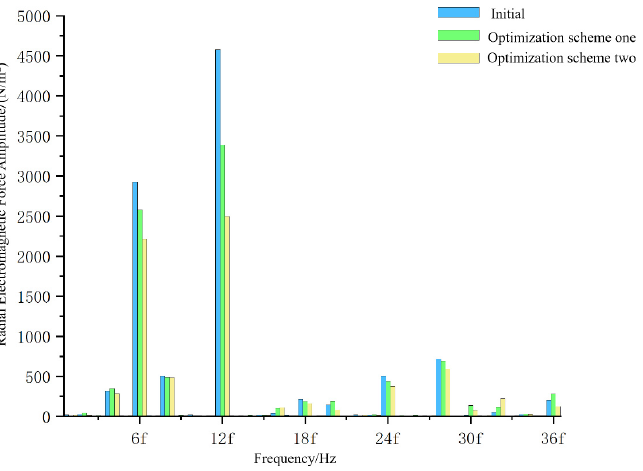
Figure 8. Zeroth-order electromagnetic force after removal of zero frequency